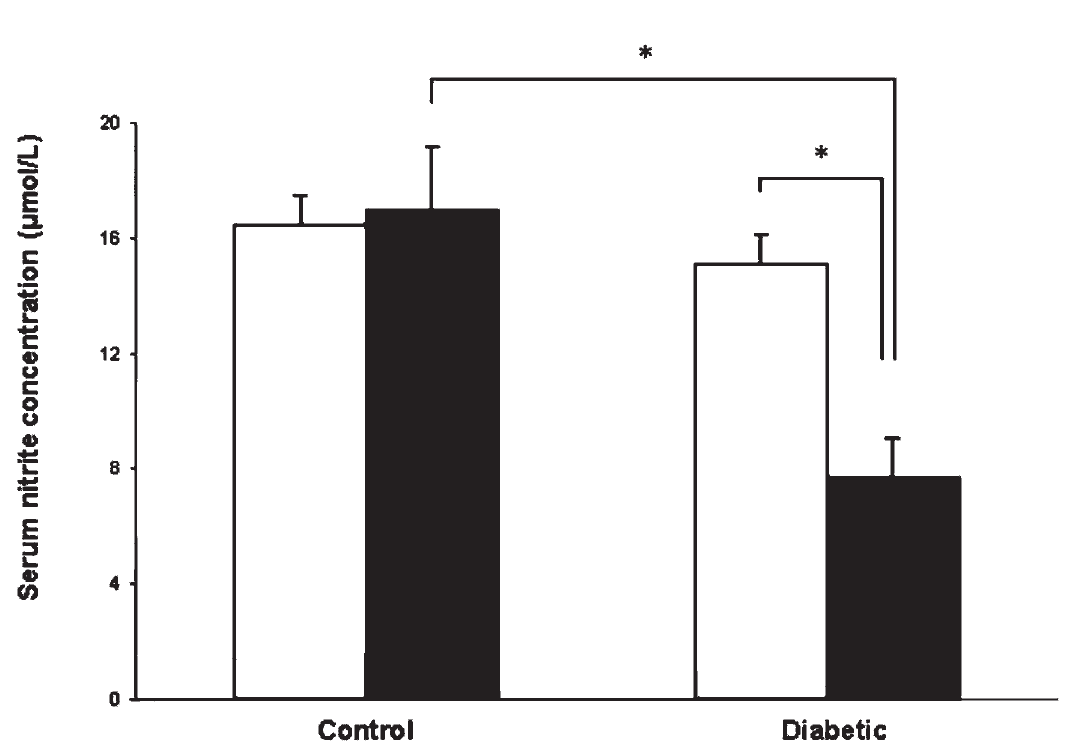
Figure 1 - Serum nitrite concentration in control and diabetic rats before and after the induction of diabetes. * p , 0.05.